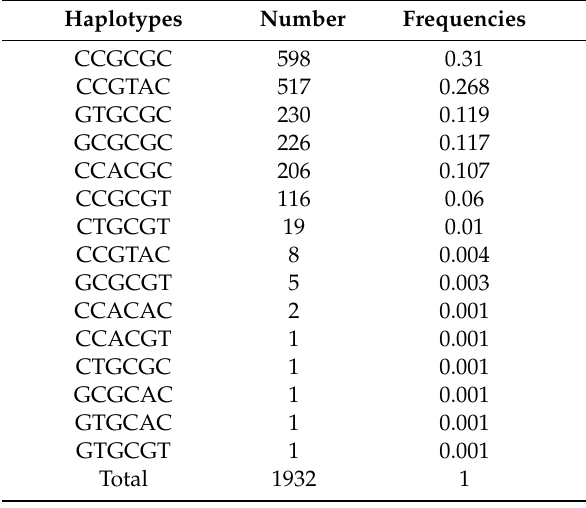
Table 3. Haplotype reconstructions for SNP S of the ACSL1 gene and their frequencies.